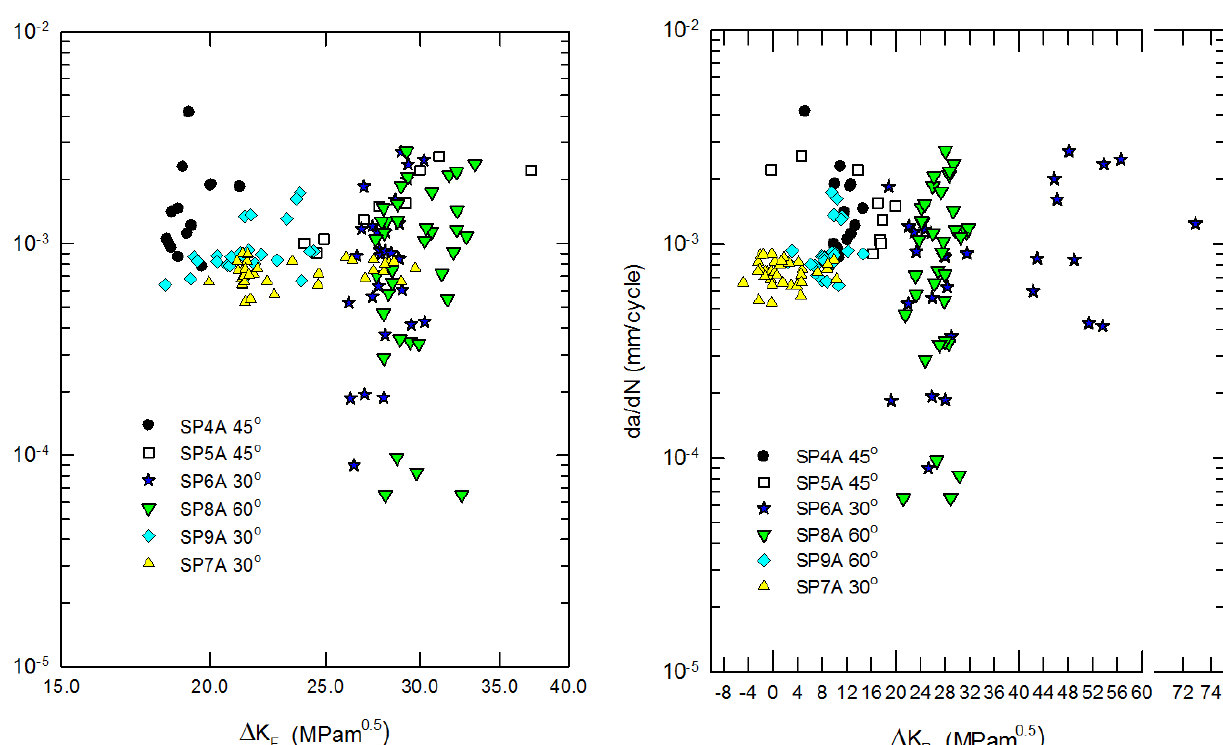
Figure 5: Fatigue crack growth rate data for all inclined crack specimens plotted against K R